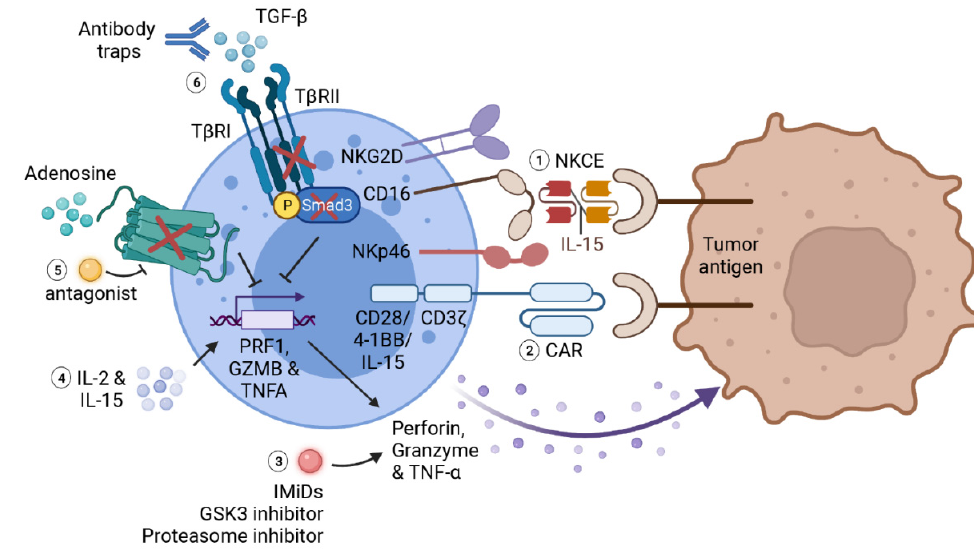
Figure 3. Summary of immunotherapies for potentiating NK effector functions. Various therapies have been developed to promote NK effector functions against cancer. ( 1 ) NKCE facilitates NK recognition of tumor antigens and stabilizes NK adhesion to tumor cells. The addition of IL-15 as a linker further promotes the activation and cytotoxic functions of NK cells. ( 2 ) Chimeric antigen recep- tor consists of a scFV of tumor antigen as extracellular antigen-binding domain, a transmembrane domain, and a signaling co-stimulatory domain including CD3 ζ , CD28 or 4-1BB. IL-15 gene can also be incorporated into a CAR gene to enhance the survival as well as effector functions of CAR-NKs. The expression of CAR effectively strengthens NK recognition, activation and cytotoxicity in the solid tumor microenvironment. ( 3 ) Immunomodulatory therapies including IMiDs, GSK-3 inhibitors and proteasome inhibitors can also boost NK-mediated cytotoxicity by increasing cytokine productions by NK cells. ( 4 ) Cytokine therapies such as IL-2 and IL-15 can largely promote NK activation and cytotoxic functions. However, the severe effects caused by systemic administration of these cytokines limit their application as monotherapies. ( 5 ) Adenosine is notorious for facilitating tumor evasion from NK-mediated immunosurveillance. Blocking adenosine signaling by genetic depletion of A2A receptor or with adenosine antagonist also augments NK cytotoxic function and cytokine production. ( 6 ) Impairing TGF- β signaling in NK cell, either with antibody traps, genetical depletion of TGF- β receptor 2 (T β RII) or downstream transcription factor Smad3, can prevent the inhibitory effects of TGF- β on NK activation and function. This figure is created with